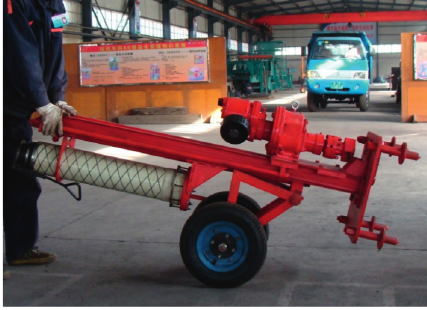
Figure 3: Roadway floor anchor cable drilling